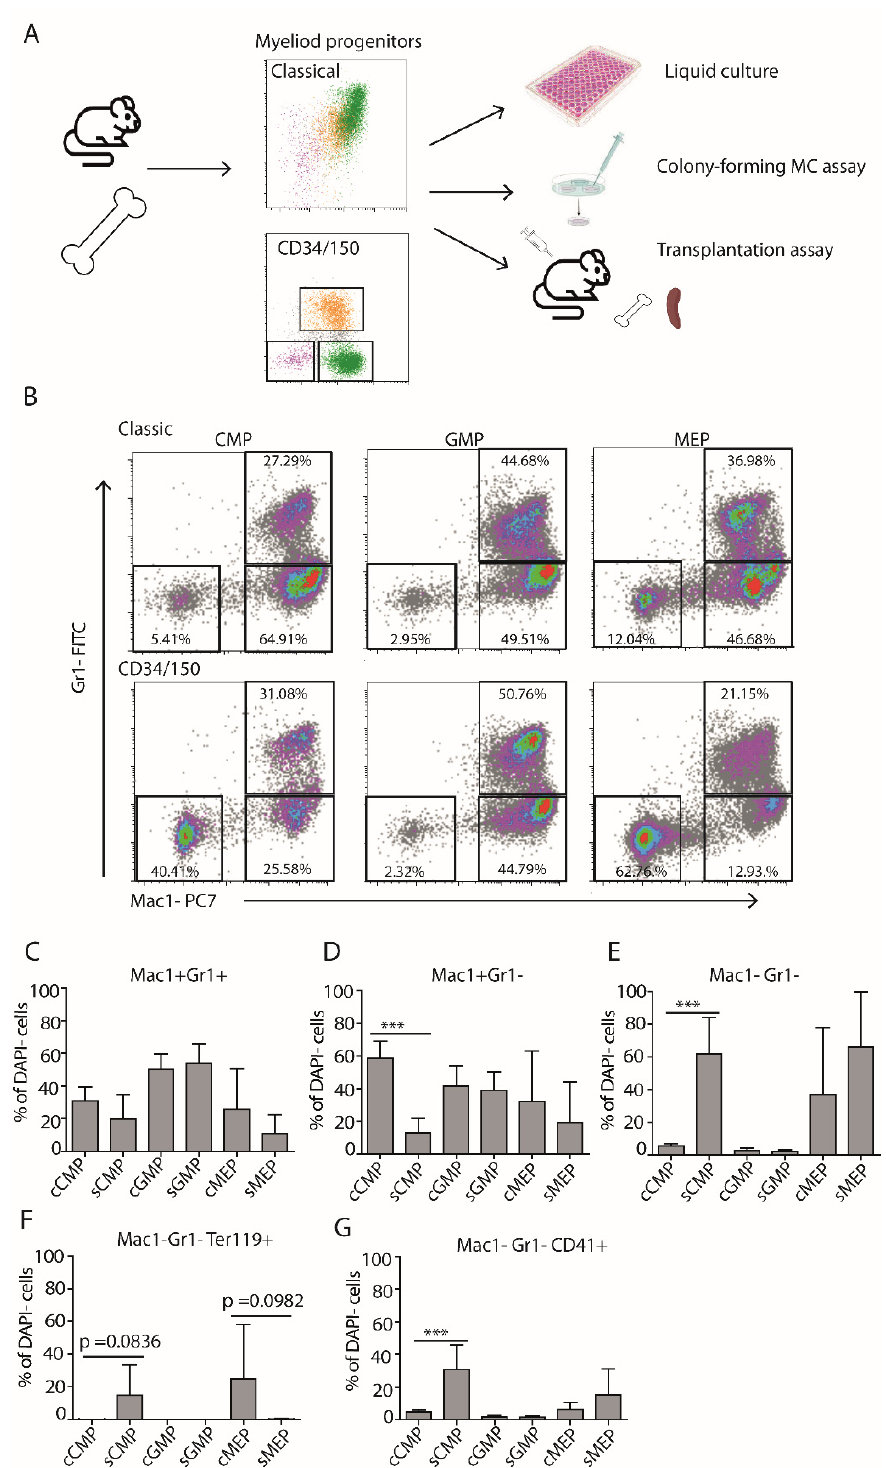
Figure 2. Comparable differentiation potential of CD34/Fc γ R and CD34/CD150 myeloid progenitor sub-populations in culture. Myeloid progenitor sub-populations were sorted either by CD34/Fc γ R or by CD34/CD150, plated and cultured for eight days. ( A ) Schematic representation of the experi- mental procedure. ( B ) Representative FACS plots showing surface expression of Mac-1 and Gr-1 in cultures derived from the defined sub-populations at day eight in culture. ( C–G ) Frequencies of the differentiated cell types in culture. Data from n = 4 independent experiments. Statistical significance was calculated by t-test, *** p ≤ 0.001.